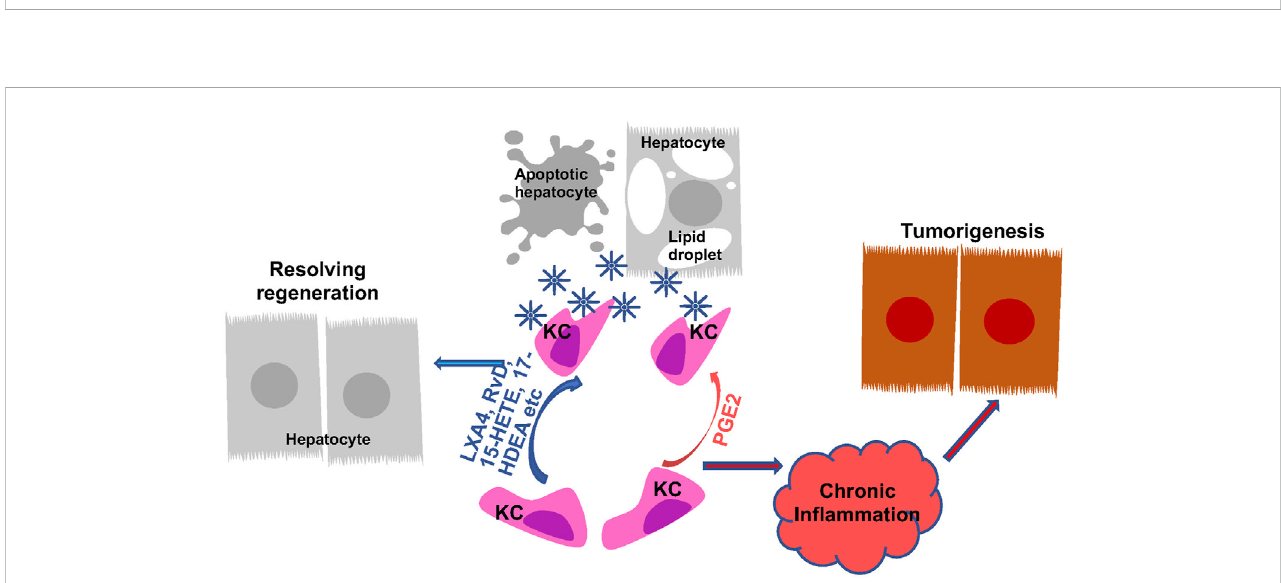
Regulation of Macrophage Phagocytosis by Eicosanoids and Oxylipins and Its Role in Liver Disease Progression. Kupffer cells (KC) are the primary phagocytic cells in the liver. Their phagocytic activities are induced in response to apoptotic cell debris, lipid particles and other signals. PGE2 and pro- resolving lipids both programs KCs to induce their phagocytosis abilities. The induced phagocytotic KCs promote resolution of in fl ammation, leading to regeneration from liver injury. When the phagocytotic activity of KCs are not induced or not suf fi cient to produce resolution, chronic in fl ammation establishes the tumor microenvironment to promote